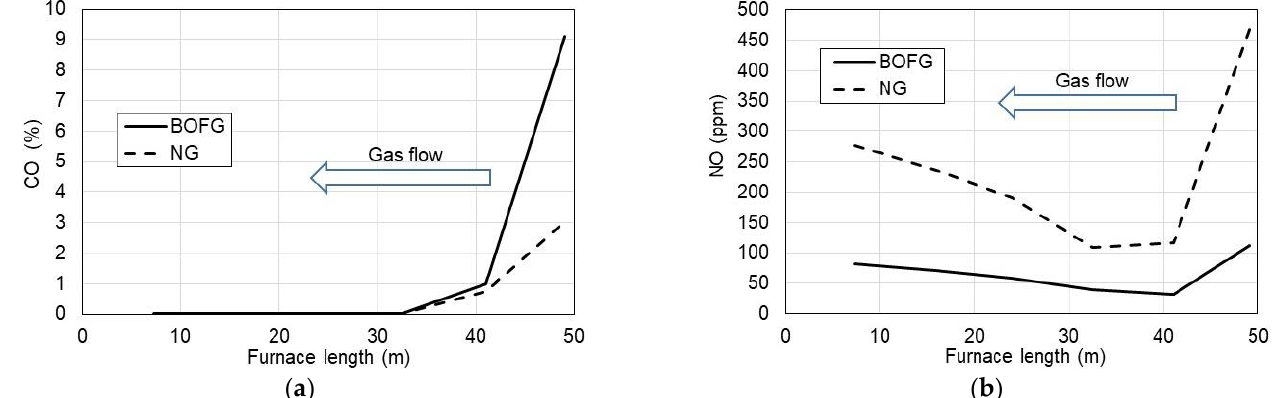
Figure 6. CO ( a ) and NO ( b ) fractions in the flue gases vs. length of the tunnel furnace fueled with NG and BOFG.